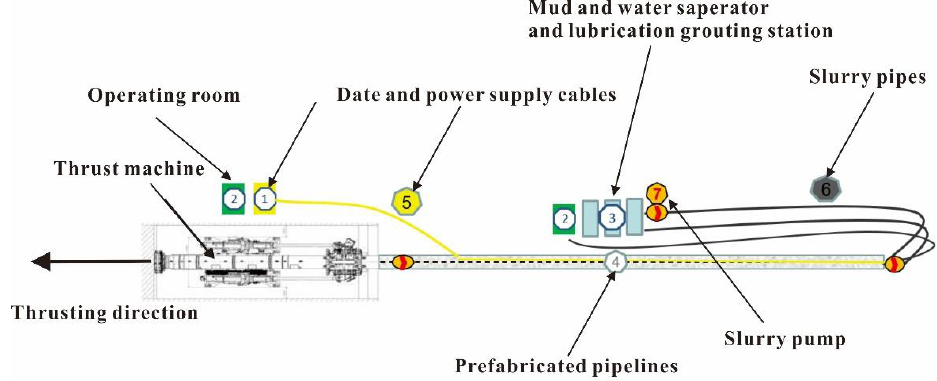
Figure 11. The project mud–water separation equipment and installed pump: ( a ) mud–water separation equipment; ( b ) installed pump.